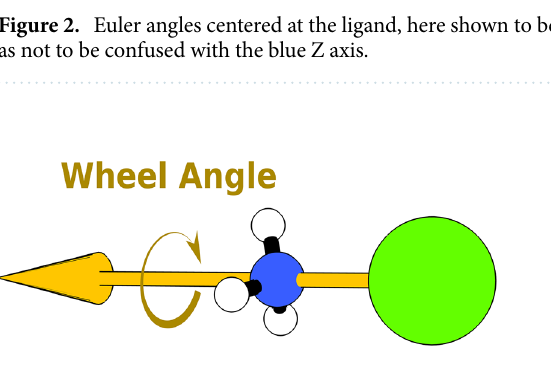
Figure 3. Examples of wheel angle for a monodentate ligand in a